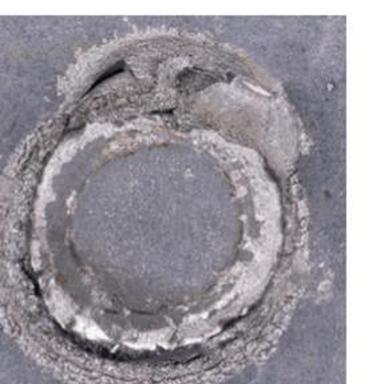
Post-failure macro-images of Usibor® 1500-AS and Ductibor® 1000-AS spot welds under shear and normal loading.